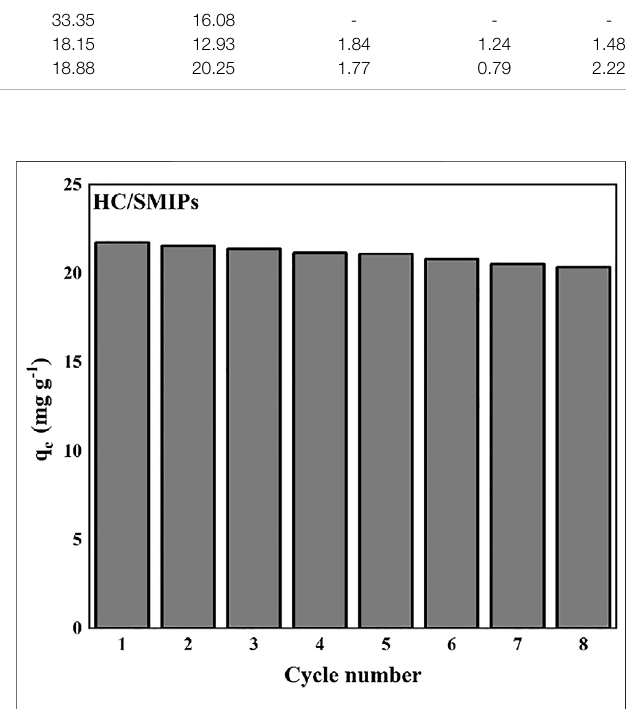
FIGURE7| Thespeci fi cbindingamountofHC/SMIPsandHC/SNIPsfor HC, osthol and rutin. FIGURE 8 | Regeneration performance of